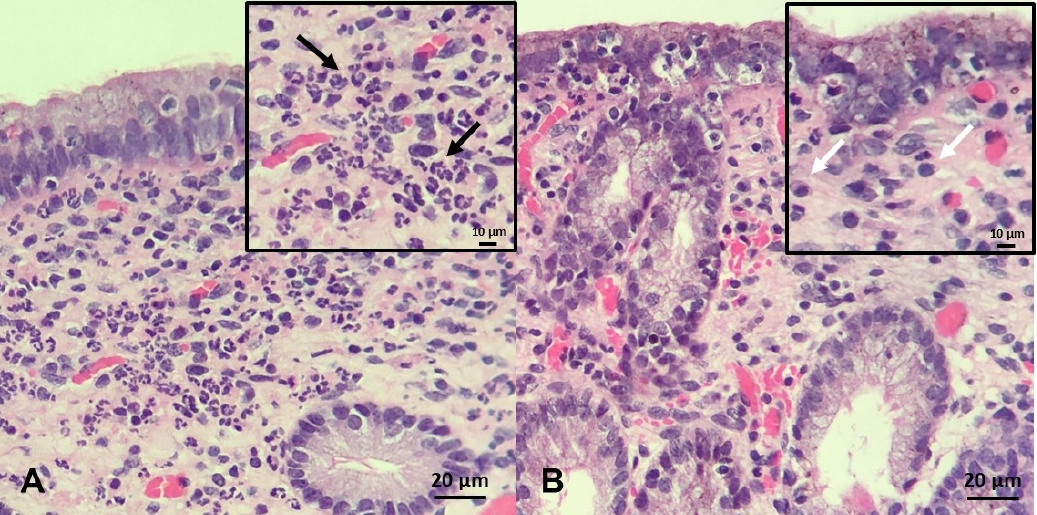
Figure 6. Endometrial biopsy specimens stained with H&E (×20 magnification, insert ×40): ( A ) A mare with acute, persistent breeding-induced endometritis characterized by a massive neutrophilic infiltrate in the stratum compactum and spongiosum; black arrows indicate neutrophils ( B ) a mare with chronic persistent breeding-induced endometritis characterized by heavy lymphocytic infiltrates present in the stratum compactum of the endometrium; white arrows indicate lymphocytes. Scale bars 10 µm inserts ( A and B ); and 20 µm ( A and B ).